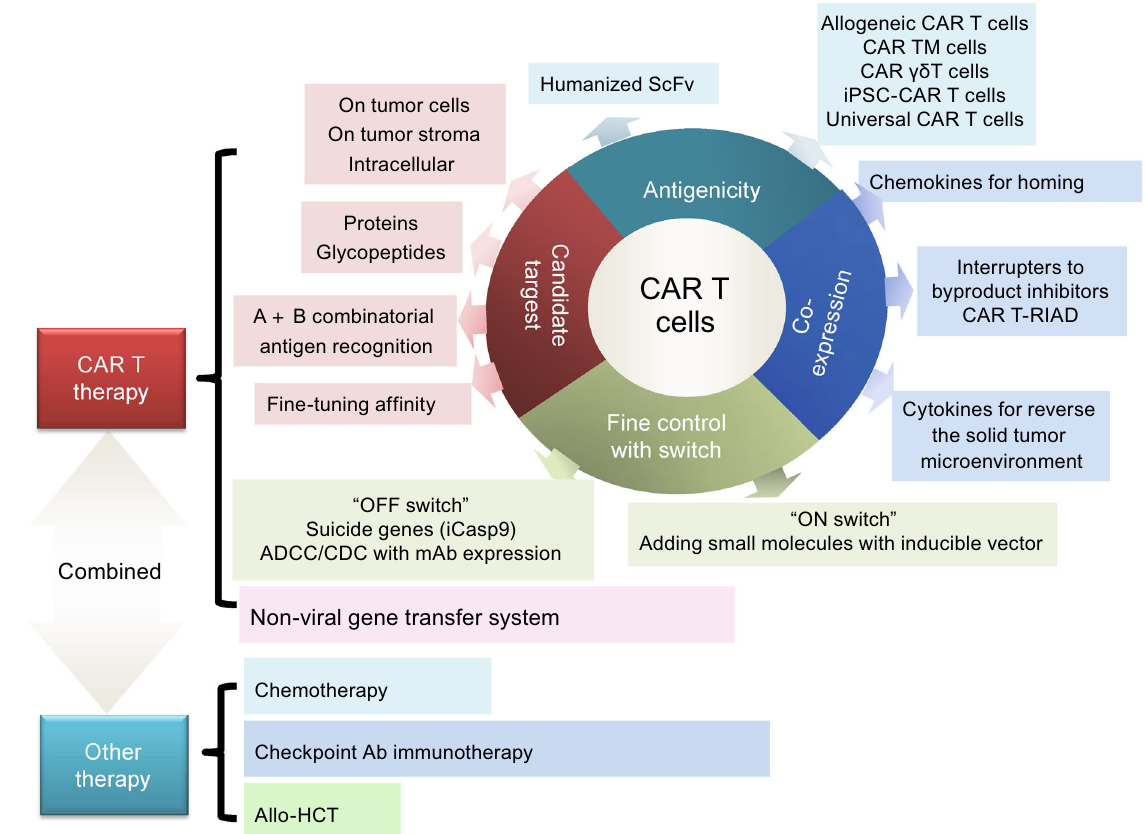
Figure 7. Strategies for CAR T therapy to overcome challenges in treating cancers. CAR T therapy is not only a complex technology that requires the optimization of the CAR T cell design but also a clinical application that can be combined with other therapies to achieve high ef fi cacy and